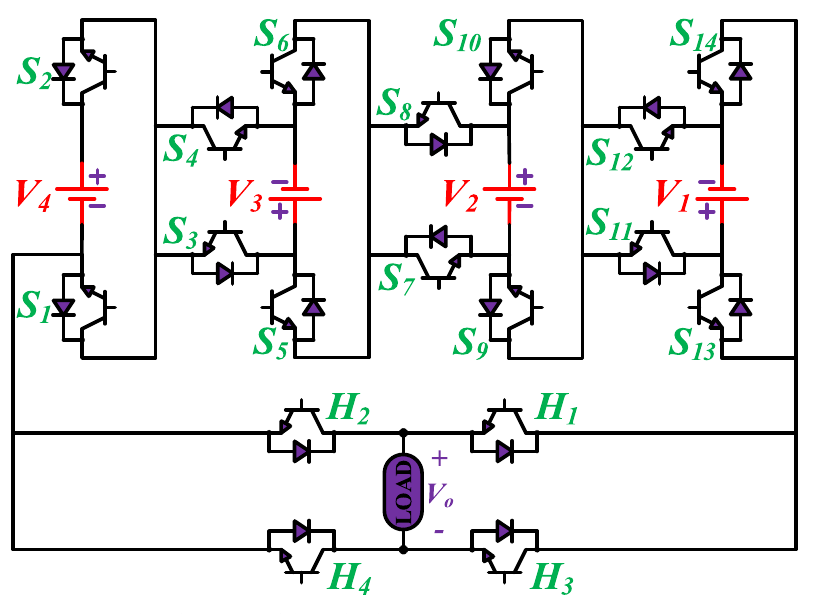
Fig 1. Proposed configuration of the 81-level MLI.